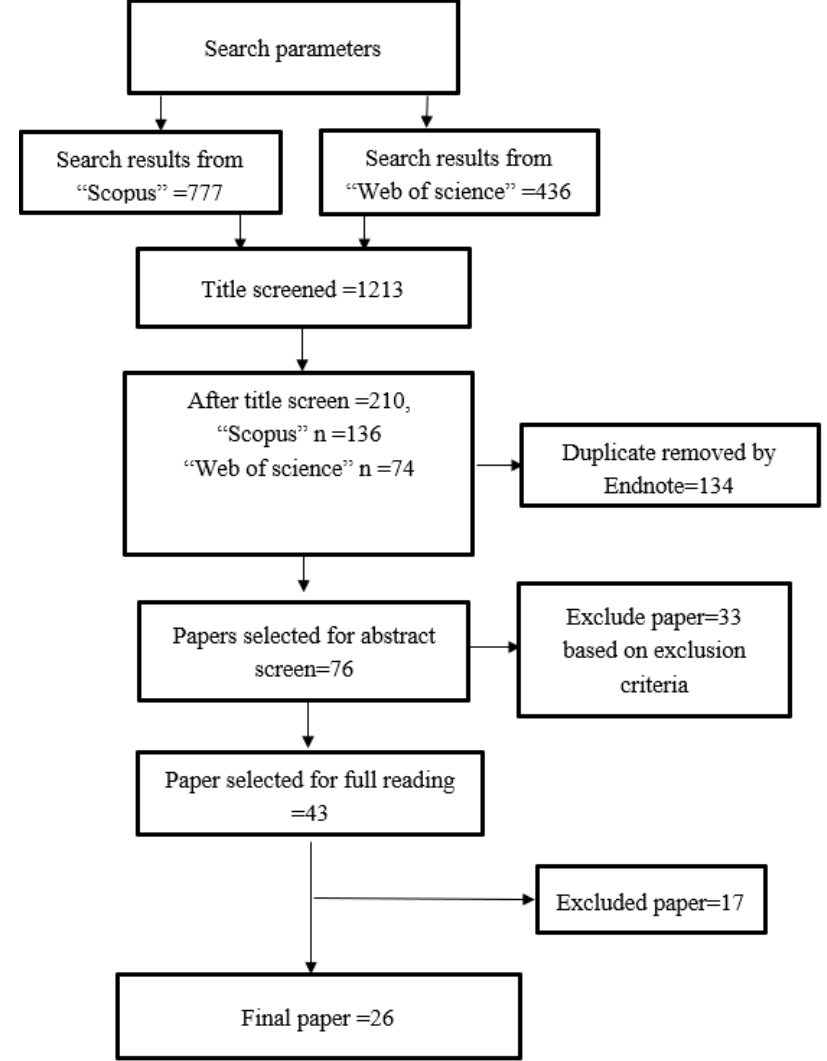
Figure 1. Prisma flow-chart on article screening.